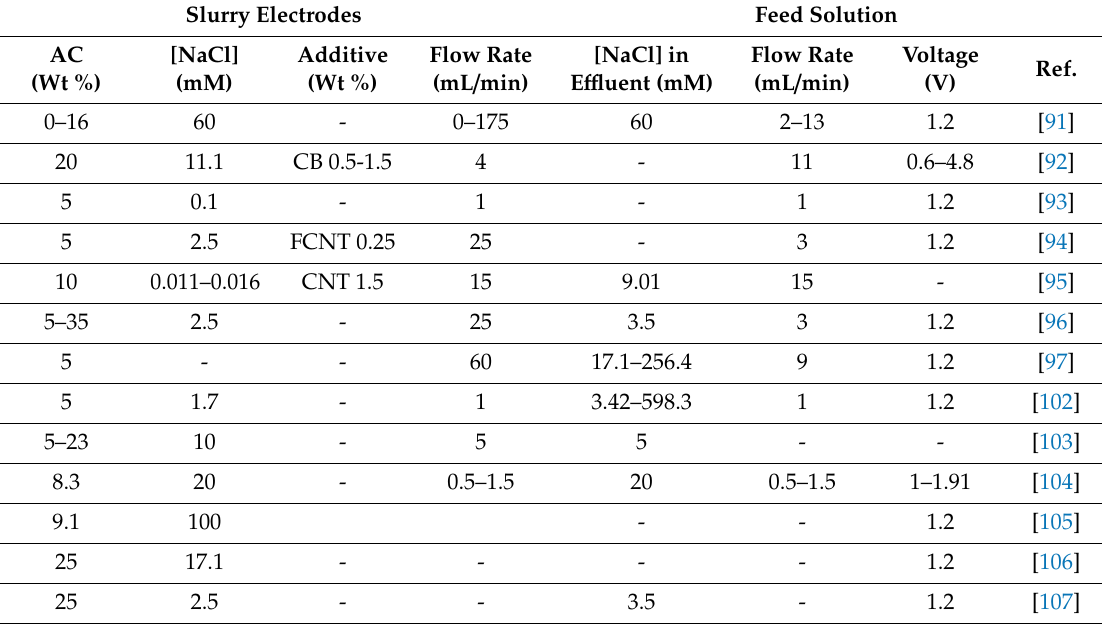
Table 5. Summary of some recent advances in operating parameters for flow capacitive deionization systems as found in